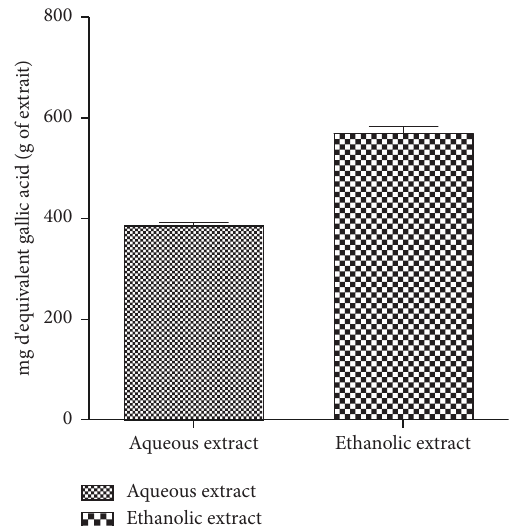
Figure 7: Total phenolic content of the aqueous and ethanol